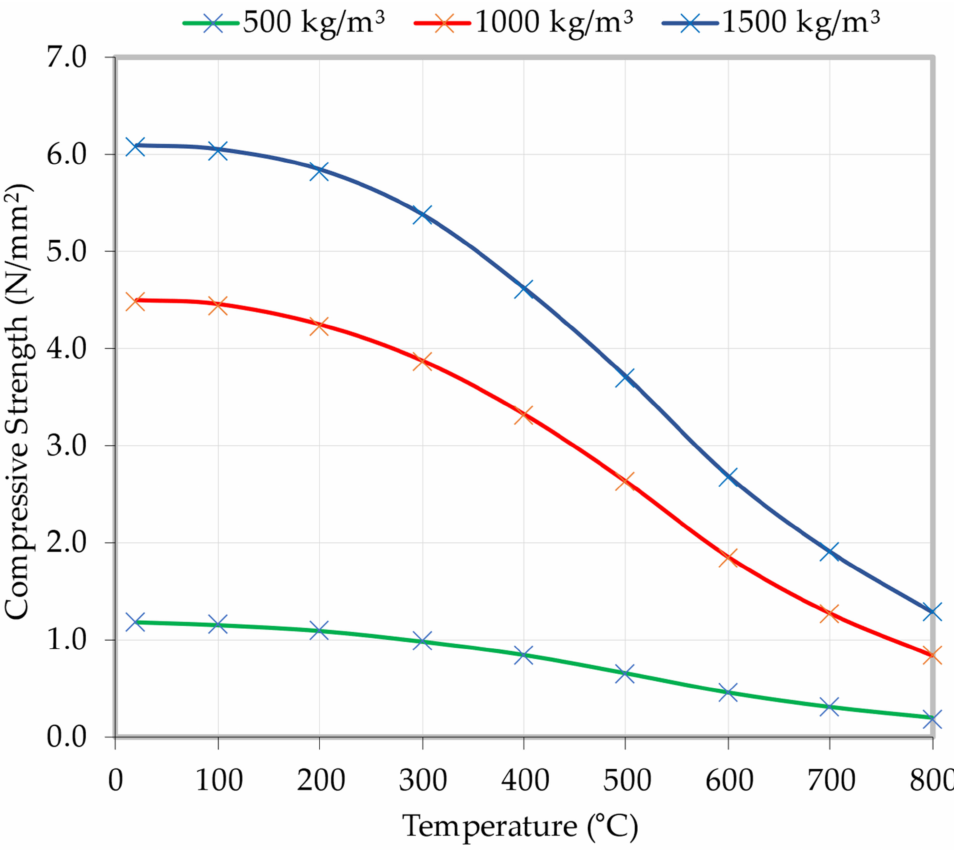
Figure 8. Influence of varying temperatures on the LFC compressive